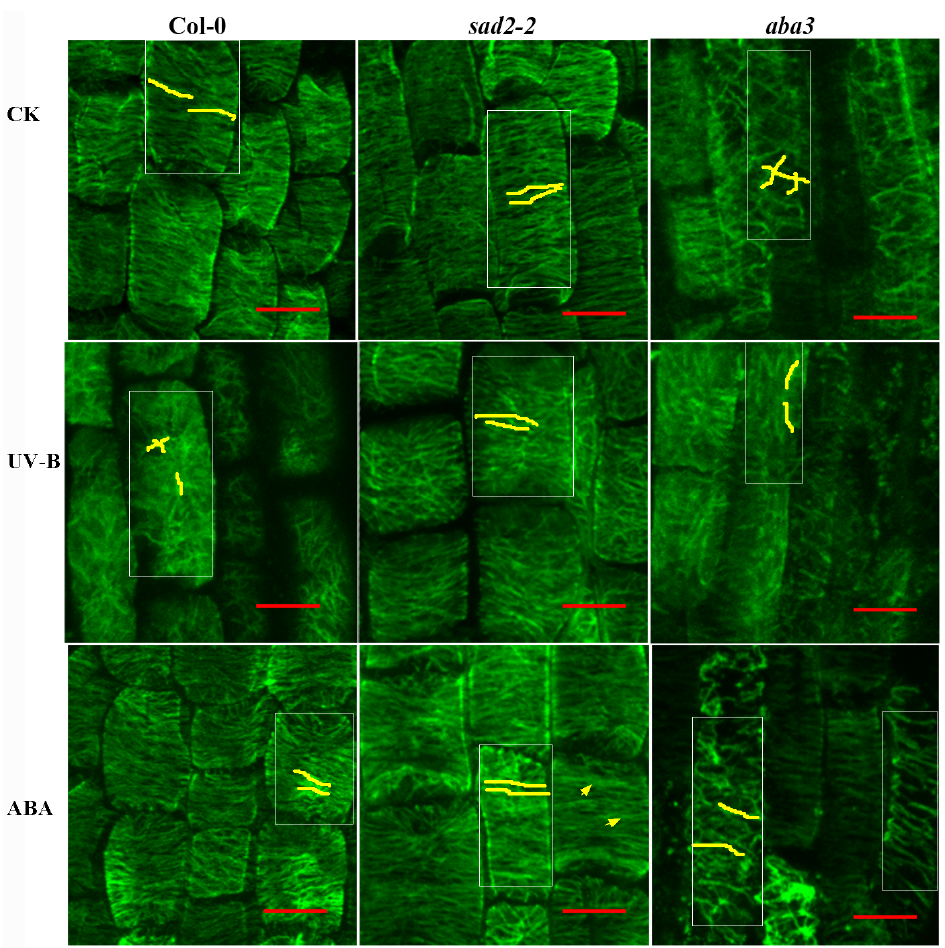
Figure 4. UV-B radiation altered the cortical microtubules in root epidermal cells from seedlings of A. thaliana wild type (Col-0), sad2-2, and aba3 mutants, three genotypes. Cortical microtubules were observed 1 h post-radiation by immunofluorescence microscopy in the root epidermal cells of seedlings treated as described above. The yellow lines processed by software Image J represent the change of length, direction, and structure of the microtubules in the selected cells, and the yellow arrows indicate bundles of the microtubules. Immunofluorescence images were collected using a Zeiss LSM 510 META confocal microscope. Each experiment was repeated three times. Scale bars in the fluorescence images of microtubules represent 10 µ